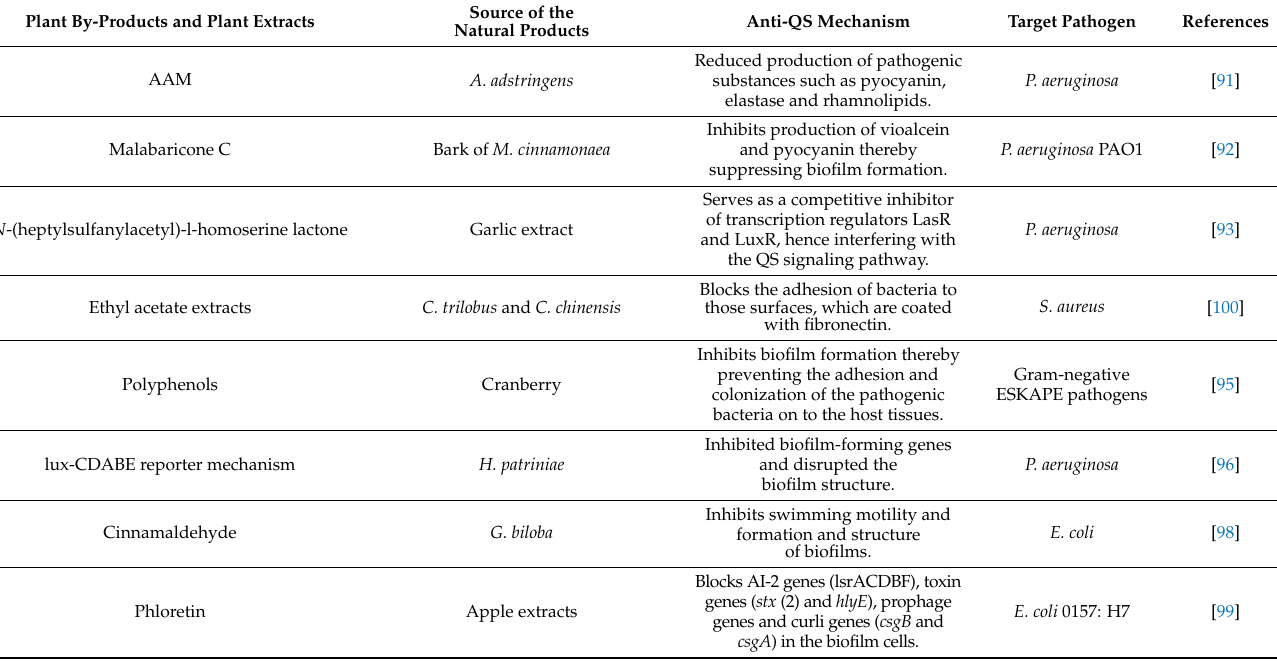
Table 3. Plant by-products and their anti-QS mechanism against target